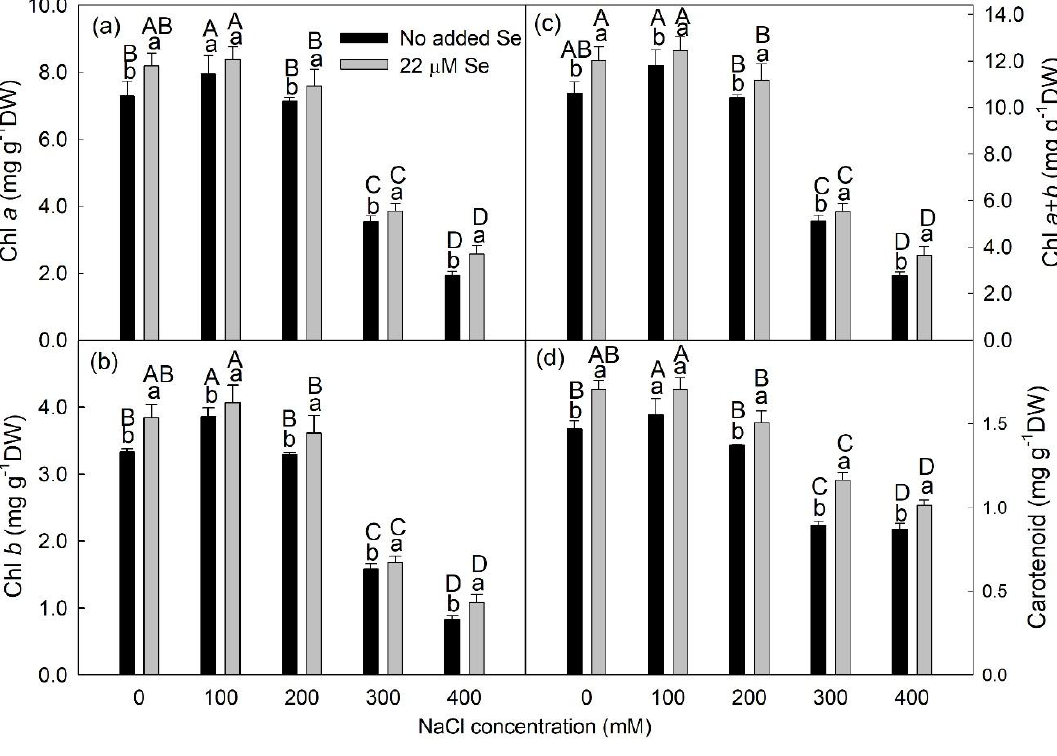
Figure 4. Means ± SD ( n = 3) of chlorophyll (Chl) a ( a ), Chl b ( b ), Chl a + b ( c ), and carotenoids ( d ) of Figure 4 leaves collected from untreated seedlings (No added Se) and Se-treated seedlings (22 µ M Se) under di ff erent NaCl concentrations. Values followed by di ff erent letters statistically significantly di ff er at p < 0.05. Means with di ff erent lowercase letters significantly di ff er by a t -test between Se treatments (No added Se and 22 µ M Se) at the same NaCl concentration. Means with di ff erent capital letters significantly di ff er by an LSD test under di ff erent NaCl concentrations in the untreated and Se-treated groups ( p < 0.05). The concentration of Se treatment was 22 µ